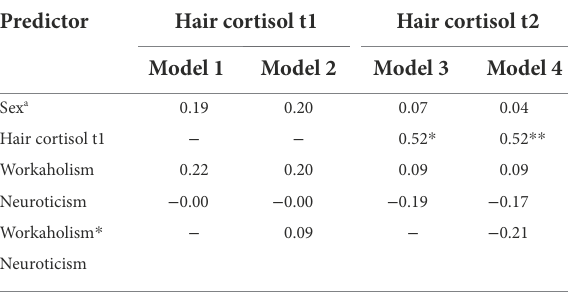
TABLE 3 Results of the multiple regression analyses predicting hair cortisol ( N = 39) and t2 ( N = 36).